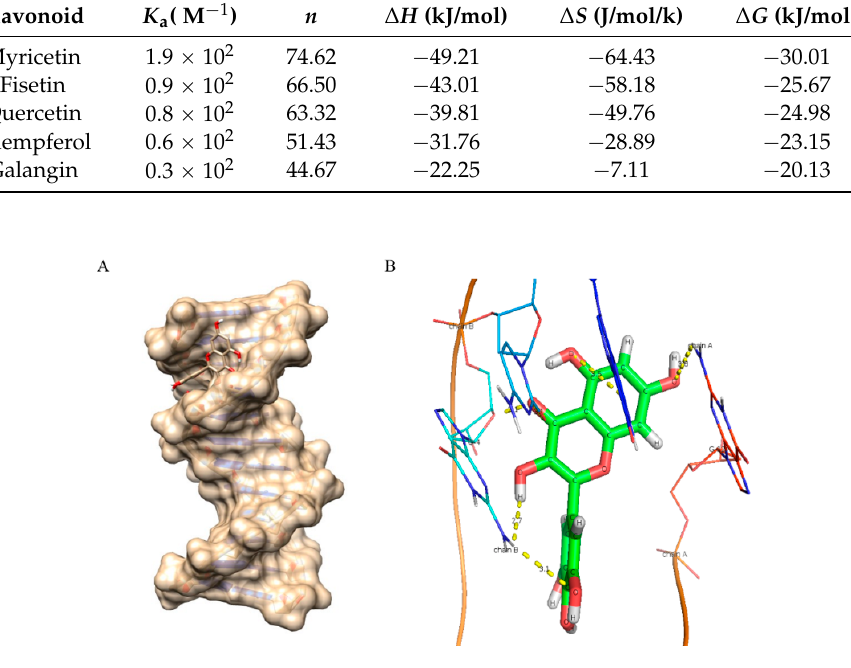
Figure 6 . Molecular docked structure of myricetin with B-DNA. ( A ) Surface view interaction of myricetin with B-DNA; ( B ) Hydrogen bonding interactions (6) and distance in Å of myricetin with dodecamer duplex of sequence (CGCGAATTCGCG) 2 (PDB ID: 1BNA).